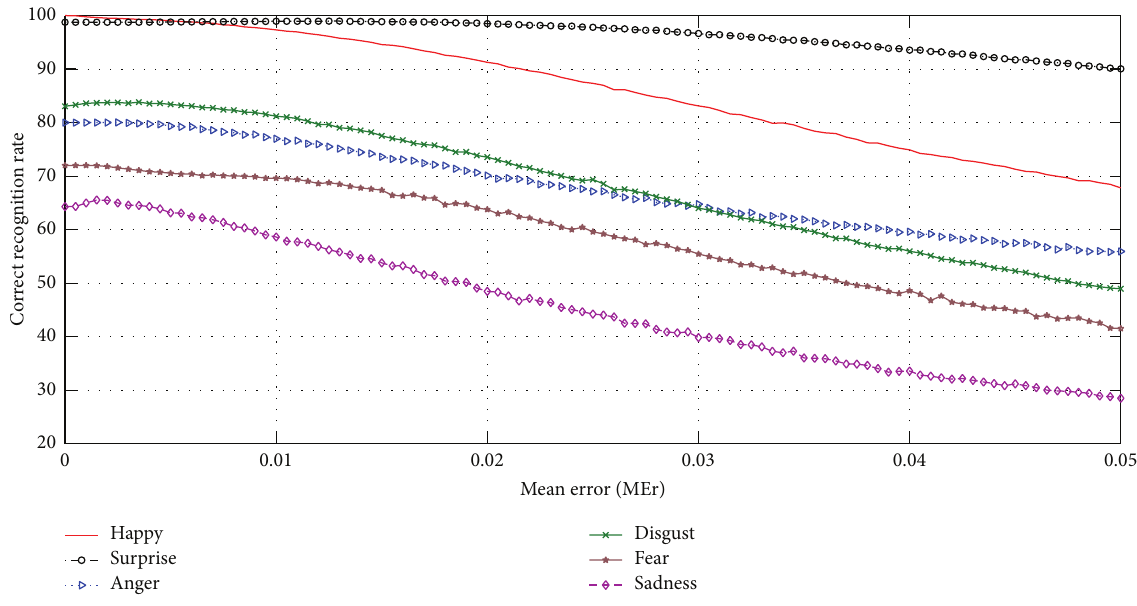
Figure 7: The recognition rate versus the synthesized localization error for six basic facial expressions. This experiment was conducted on CK+ database with the help of SVM classifiers. MEr is the Euclidean distance between the detected point and the ground truth divided by width of the detected face.